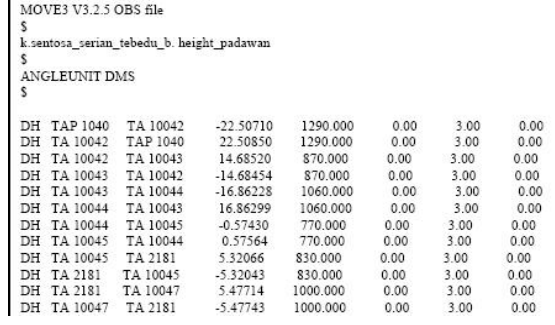
Figure 4. Sample of JUPEM’s data in MOVE3 format